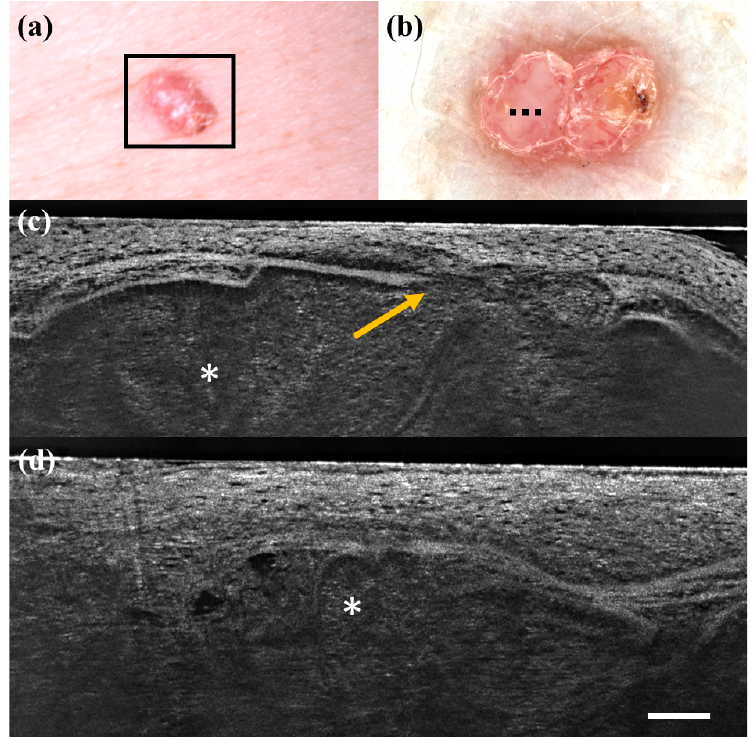
Figure 5. Trichillemoma diagnosed as basal cell carcinoma under dermoscopy and line-field confocal optical coherence tomography (LC-OCT). Clinical ( a ), dermoscopic ( b ), and LC-OCT images ( c , d ). Dermoscopy shows a pinkish background with linear vessels and scales. LC-OCT reveals lobular structures (asterisk) with clefting, palisade, “feuilletage”, and connection with the epidermis (orange arrow). Dashed line ( b ) indicates the approximate area of the LC-OCT imaging. White scale bar in LC-OCT images: 100 μ m.